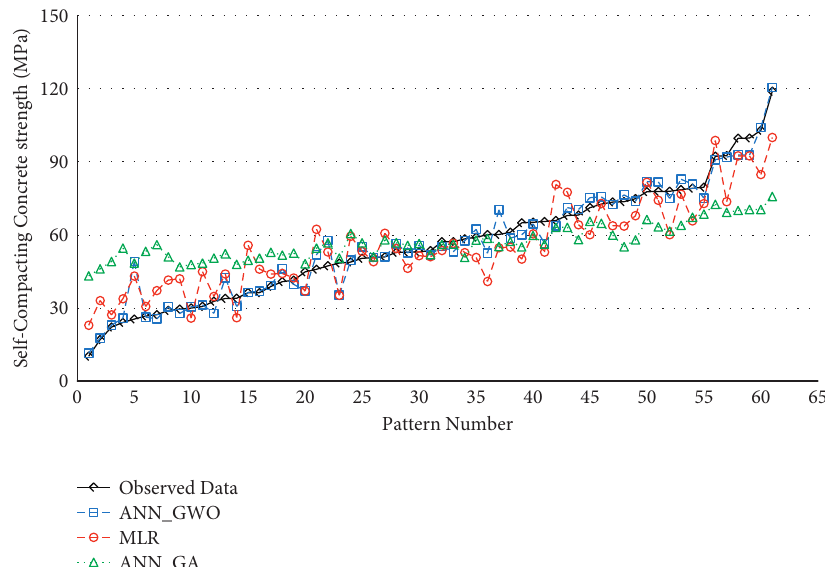
Figure 15: Prediction comparison of all models using testing